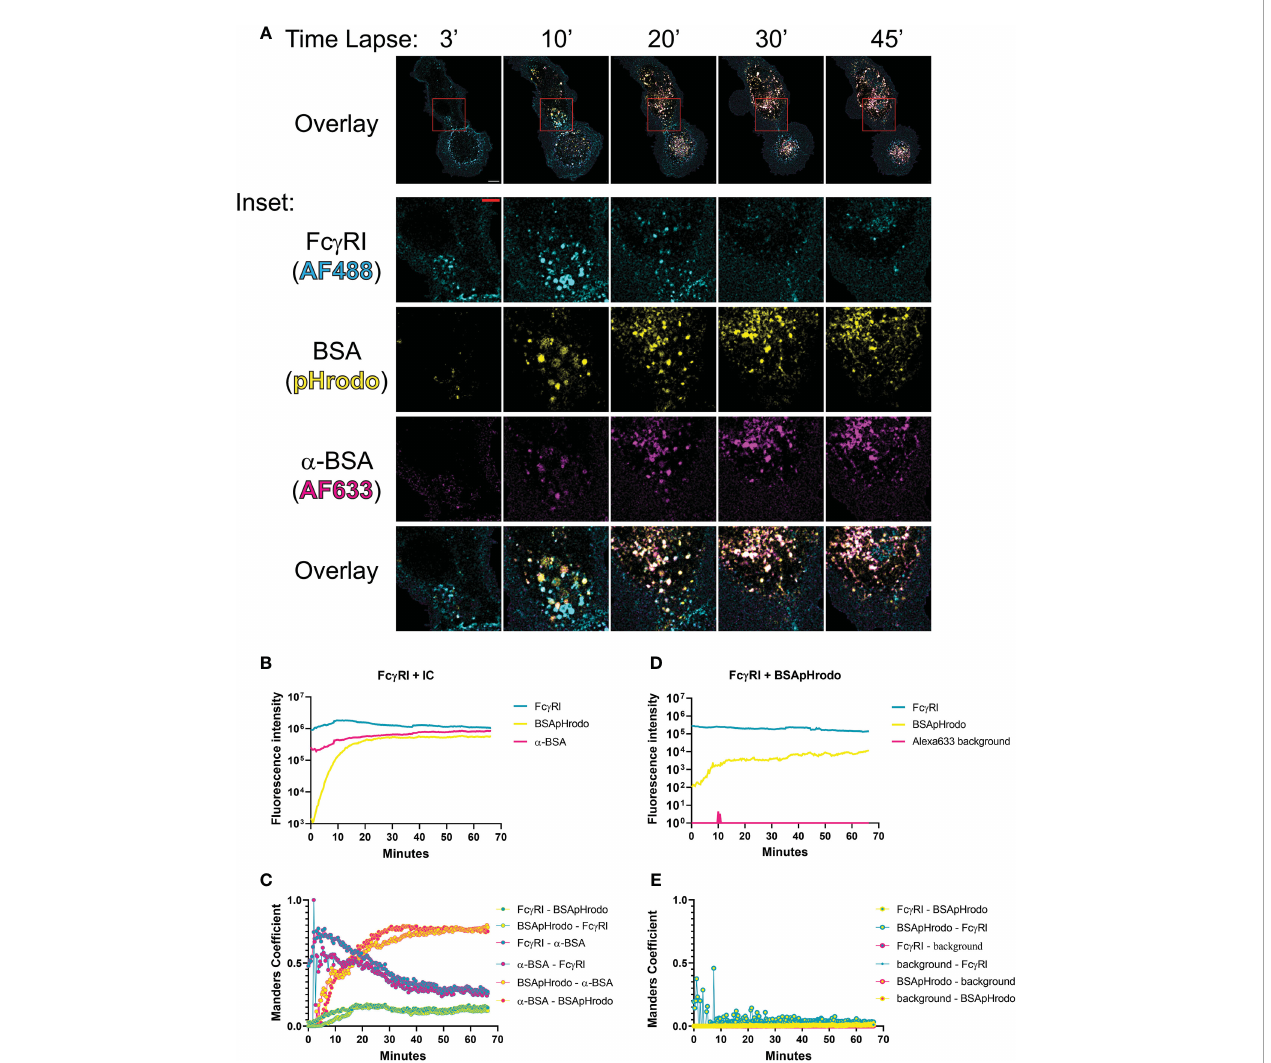
FIGURE 7 Temporal-spatial interaction between Fc g RI and IgG during internalization of immune complex (IC). (A) Time lapse of fl uorescent images showing Fc g RI- mediated phagocytosis of IC by live monocyte-derived macrophages. The boxed area (10 m m x 10 m m) was further enlarged to show the distribution of IgG(Alexa633), BSA(pHrodo) and Fc g RI(Alexa488) with a scale bar of 5 m m. (B, D) Time-dependent fl uorescent intensities of labeled Fc g RI, BSA and anti- BSA during Fc g RI-mediated internalization of BSA-anti-BSA immune complex (B) or its control without anti-BSA (D) . The fl uorescence of pHrodo increased as the pH declined. More BSA are internalized in Fc g RI-mediated process (B) than spontaneous internalization (D) . (C – E) Manders coef fi cient analyses of live cell images for colocalization between pairs of fl uorescent probes during Fc g RI-mediated internalization of BSA-anti-BSA immune complex (C) or its control without anti-BSA (E) . Manders coef fi cients were calculated for pairwise colocalization between Fc g RI, BSApHrodo, and anti- BSA antibody with respect to either fl uorescent probe. For example, Fc g RI- a -BSA refers to the percentage of Fc g RI (cyan) that colocalizes with anti-BSA (magenta), while a -BSA-Fc g RI is magenta-cyan and is the percentage of a -BSA that colocalizes with Fc g RI. While BSA and anti-BSA remain colocalized throughout the duration of the live cell imaging, Fc g RI showed optimal colocalization with anti-BSA at the beginning and dissociated at a later time. Fc g RI was stained by Alexa488 antibody(cyan), BSA protein was labeled with pHrodo(yellow), and anti-BSA antibody was labeled with Alexa633